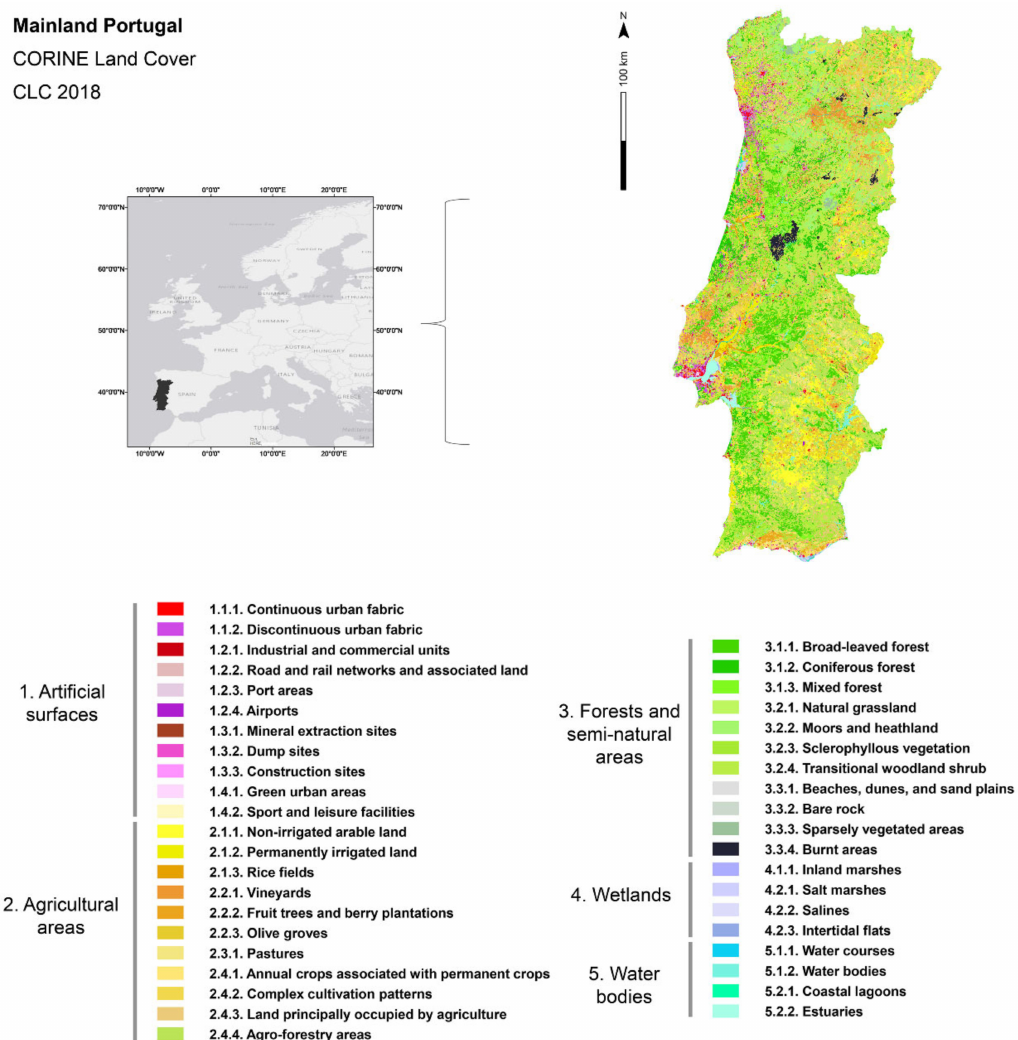
Figure 1. Study area—National map of mainland Portugal, according to their land use/land cover classes. Data source: CORINE Land Cover (Copernicus,